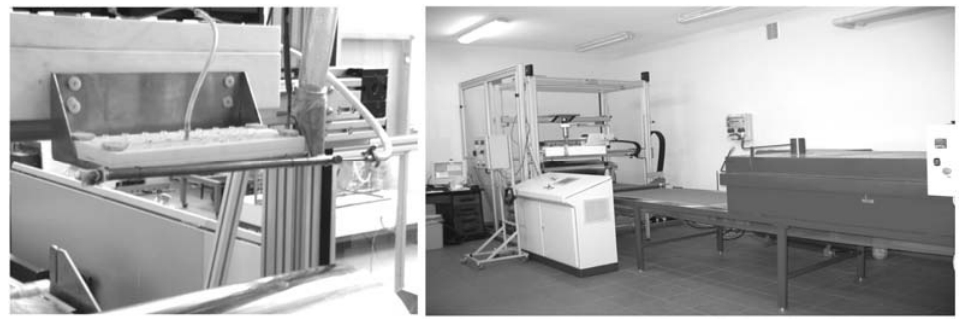
Figure 16. Photograph of the modified system for